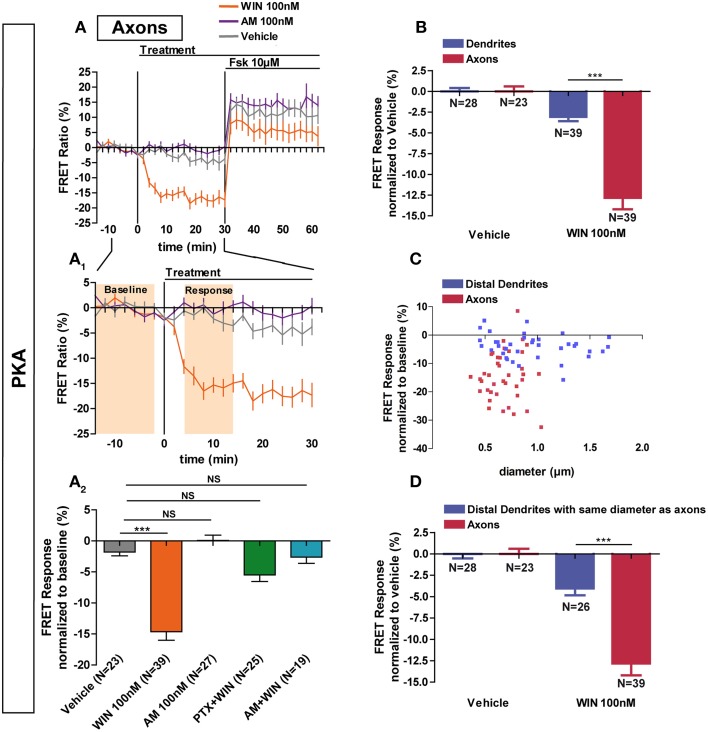
Axonal CB1R signaling differs from dendritic signaling. (A) Averaged axonal responses of AKAR4-Kras expressing neurons, as shown on Figures 1E,F. The FRET ratio normalized to baseline was calculated for each neuron with a time-resolution of 2 min. The curves represent mean ± S.E.M. of the FRET ratio for all imaged neurons at each time point. Addition of agonist WIN 100 nM but not of vehicle or inverse-agonist AM281 100 nM (AM) at t0 results in rapid high-amplitude FRET ratio decrease. At 30 min, adenylyl-cyclase activator Forskolin (Fsk) was added at 10 μM, inducing a saturating increase of the FRET ratio. A1: Zoom between −t14 and t30 of A shows significant modulation of basal PKA activity after activation of CB1Rs. A2: FRET responses were calculated as the mean response between t4 and t14 min (shaded zone labeled “Response” on A1), using data normalized to the baseline (shaded zone between −t14 and −t2, labeled “Baseline” on A1). Implication of Gi/o-proteins was shown by the specific inhibitor pertussis toxin (PTX), applied overnight at 100 ng/mL before the beginning of the experiment. The WIN effect was CB1R-induced as shown by pre-treatment with the CB1R-specific antagonist AM281 (1 μM, 3 h before the beginning of the experiment). (B) Vehicle-normalized FRET response to WIN is significantly stronger in axons than in dendrites. (C) Individual FRET responses in axons and distal dendrites are represented in function of their respective diameter. For each group (distal dendrites and axons), a Pearson correlation test was calculated showing no correlation between FRET response and diameter (rdistal dendrites = −0.065 and raxons = 0.03649). (D) Distal dendrites having the similar diameter than axons still display significantly weaker vehicle-normalized FRET responses to WIN compared to axons. Data information: Data are expressed as means ± S.E.M.; Statistical analysis was realized with one-way ANOVA followed by Newmann-Keuls post-test (A2) or unpaired t-test (B,D); NS p > 0.05, ***p < 0.001.